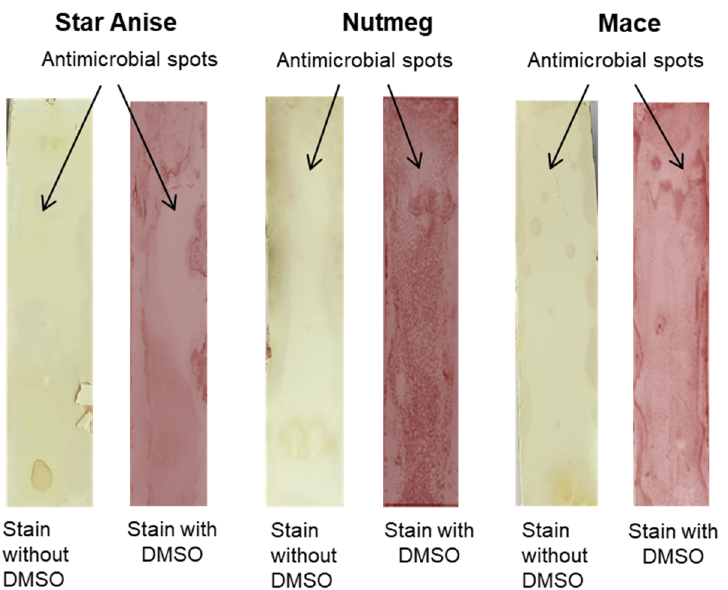
Figure 10. Antimicrobial activities of phyto-formulated CuNPs by TLC–direct bioautography, showing the appearance of antibacterial spots in the presence and absence of